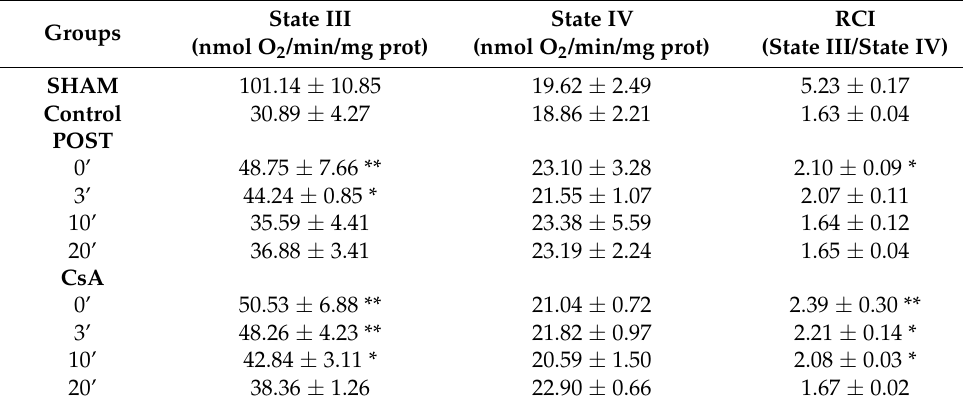
Table 2. Mitochondrial oxygen consumption evaluated by measuring state III, state IV, and RCI (res- piratory control index = state III/state IV). Higher RCI was maintained in the CsA group until 10 min of delayed intervention. Abbreviations: CsA for cyclosporine A, POST for ischemic postconditioning. N = 6 hearts/group. * p < 0.05. ** p < 0.01 vs